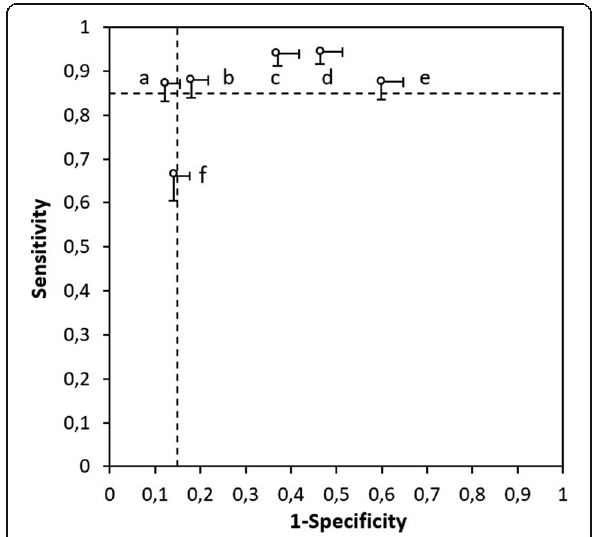
Fig. 4 External validation of the diagnostic accuracy of rules-based selective testing strategies (figure derived from Cohen and colleagues [16]). Graph shows sensitivity and specificity estimates with their one-sided rectangular 95% confidence regions. Numbers indicate the rules-based selective testing